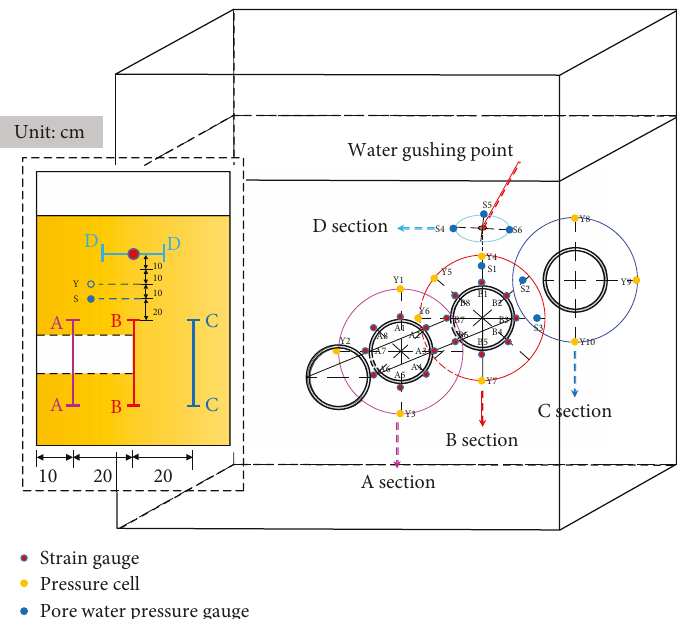
Figure 5: Monitoring section and measuring points ’ layout.